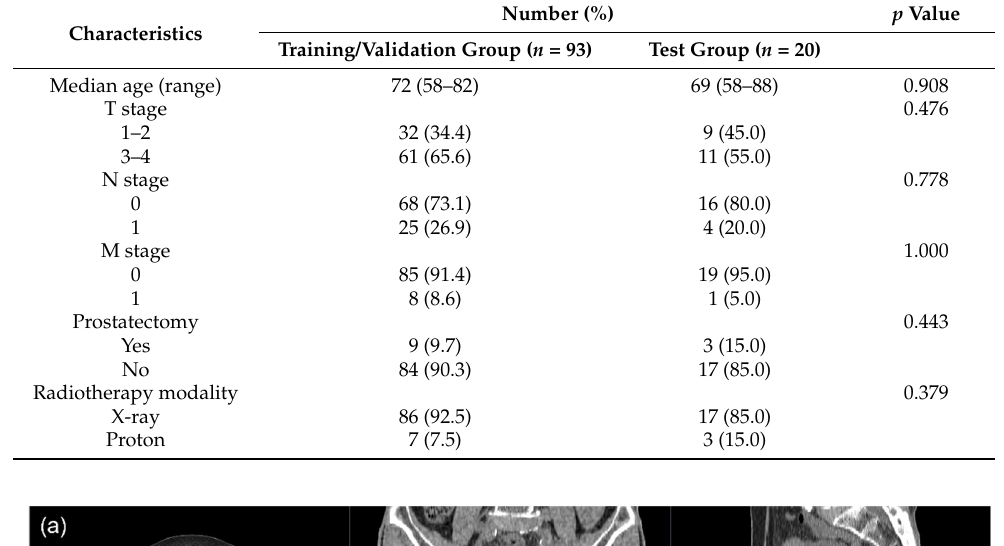
Table 1. Patients’ characteristics of training and test sets ( N = 113).